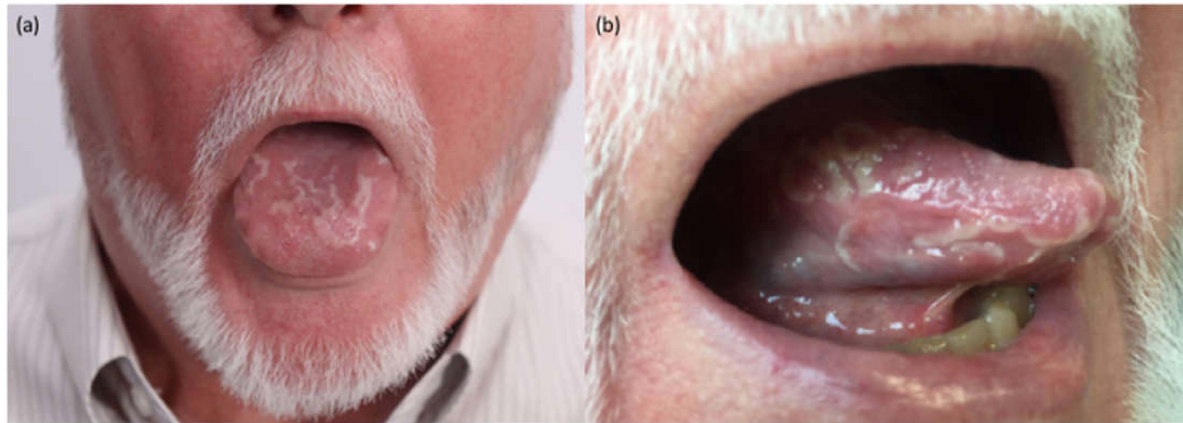
Figure 6. Clinical presentation of a benign migratory glossitis or geographic tongue after the first cycle of nivolumab affecting the dorsal ( a ) and the lateral ( b ) surfaces of the